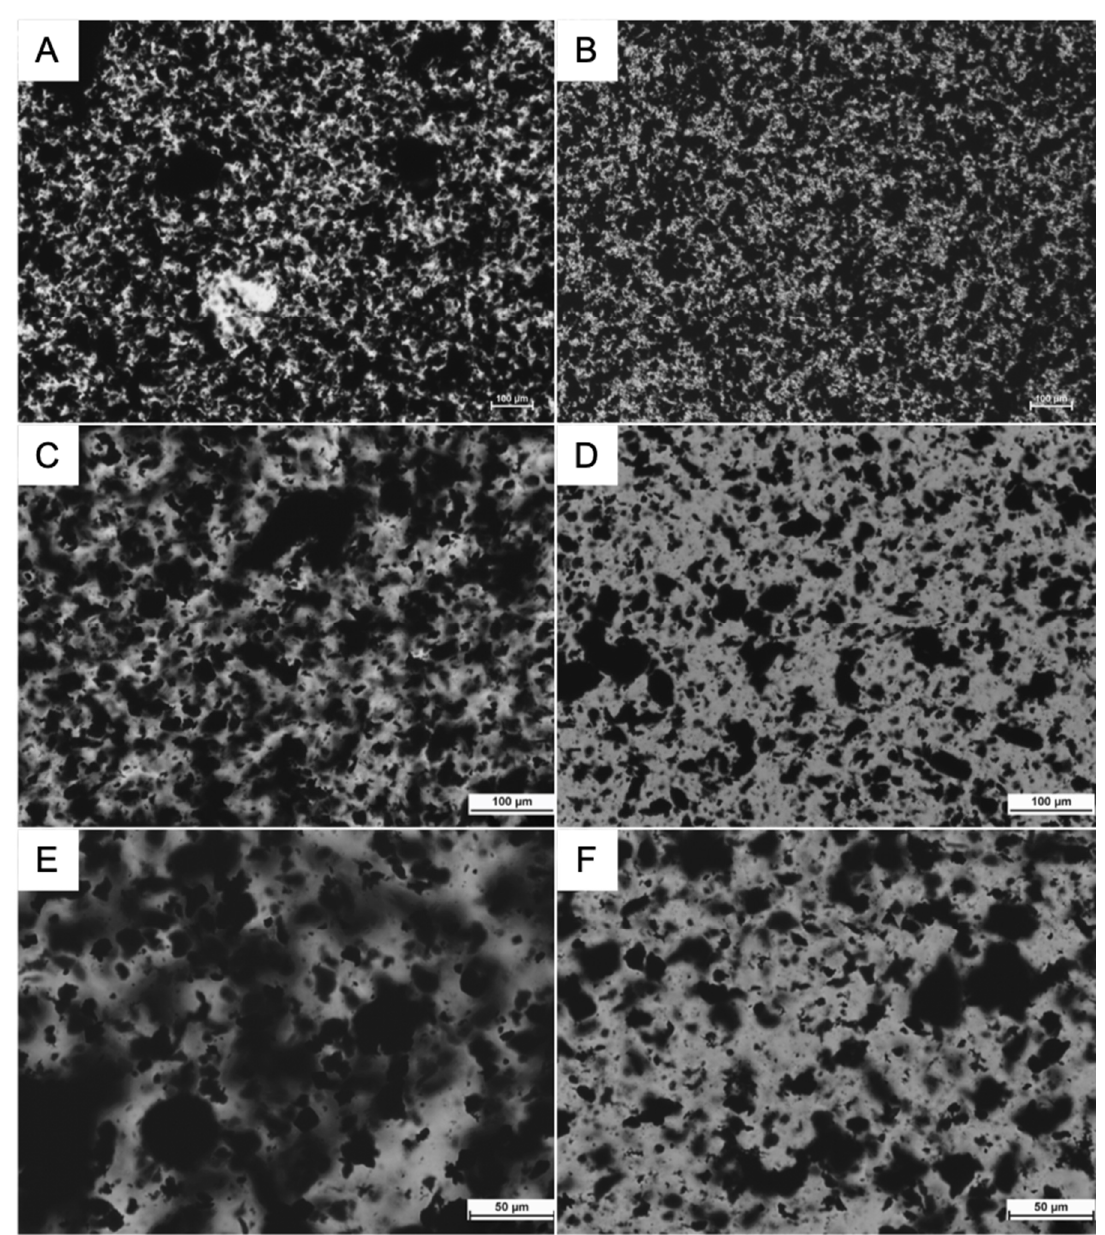
Figure 3. Microscope images of carbon black, 1% CMC, graphite after ( A ) 2 h of mixing (50×); ( B ) 4 h of mixing (50×); ( C ) 2 h of mixing (100×); ( D ) 4 h of mixing (100×); ( E ) 2 h of mixing (200×); ( F ) 4 h of mixing (200×).